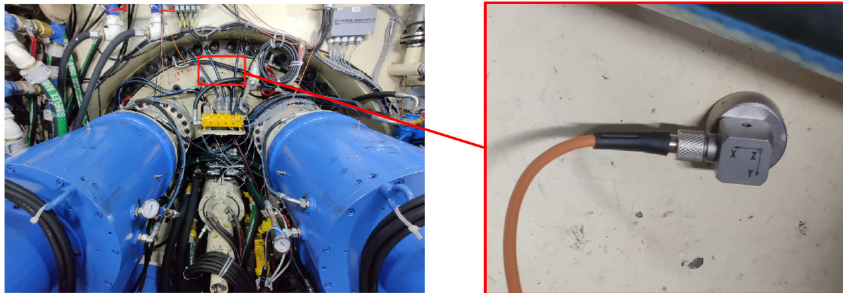
Figure 11. The vibration test device of the TBM main drive system. Table 4. Comparison of experimental and simulated values of the frequencies of the TBM main drive system.